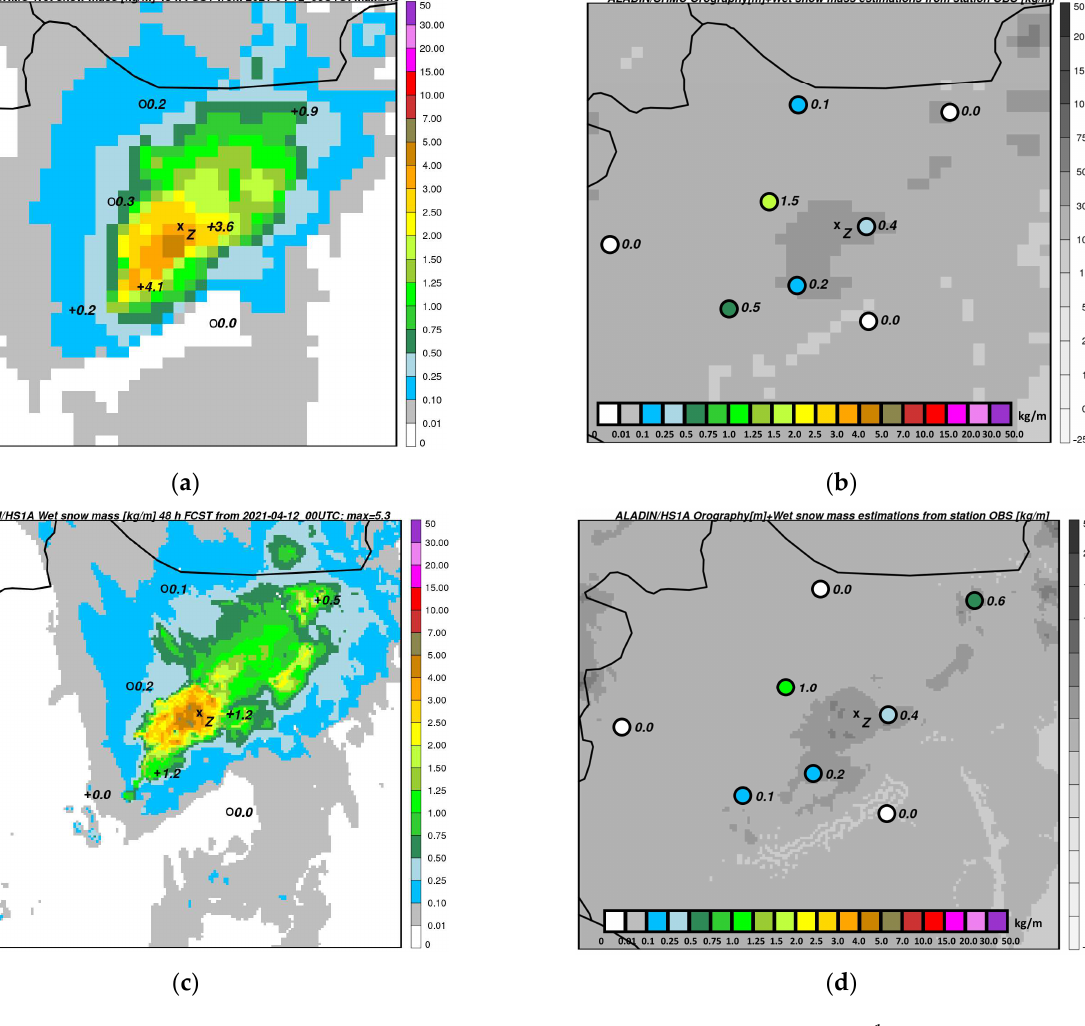
Figure 13. ( a ) Forecast of cumulated wet snow mass (shaded, kg·m −1 ) from the ALADIN/SHMU run based on 12 April 2021 00 UTC and valid for 14 April 2021 00 UTC in the region of northwestern Hungary (domain shown in Figure 6b). The meaning of numbers and symbols is the same as in Figures 3 and 12; ( b ) ALADIN/SHMU model orography (shaded, m). Numbers and colored circles show the mass (kg·m −1 ) estimated from both station observations and NWP data and cumulated for the same period as in ( a ); ( c ) as in ( a ) but for the ALADIN/HS1A model run; ( d ) as in ( b ) but for estimations using ALADIN/HS1A inputs.